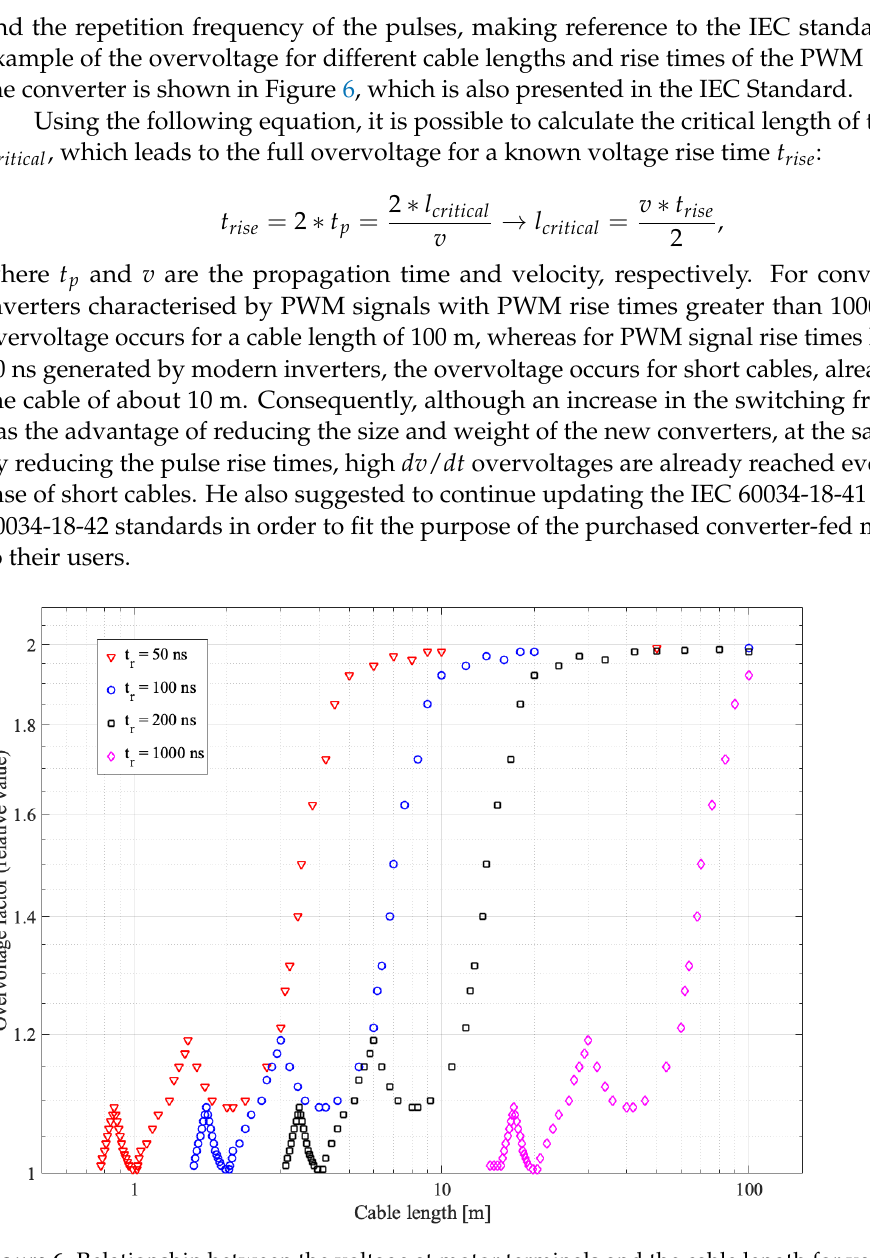
Figure 6. Relationship between the voltage at motor terminals and the cable length for various rise times of a PWM signal; figure extrapolated from